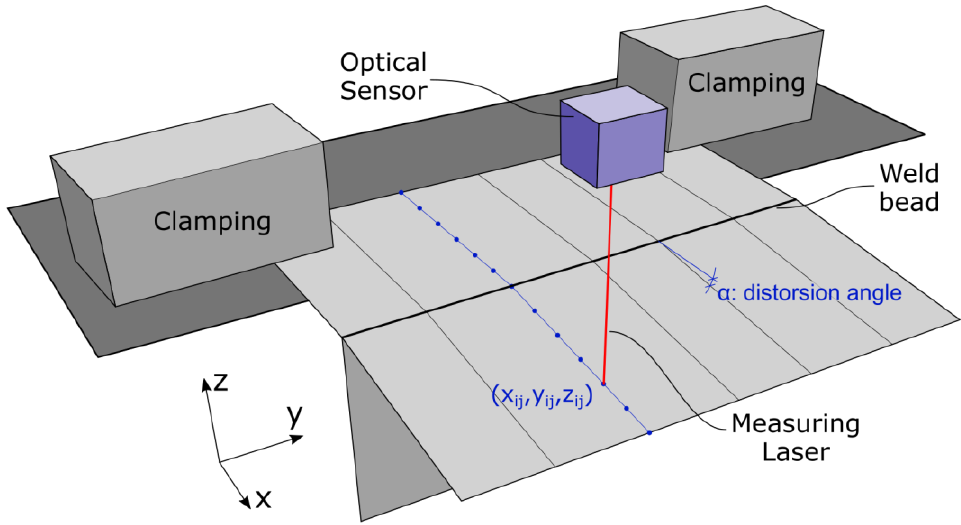
Figure 4. Micrograph showing molten weld pool and HAZ.